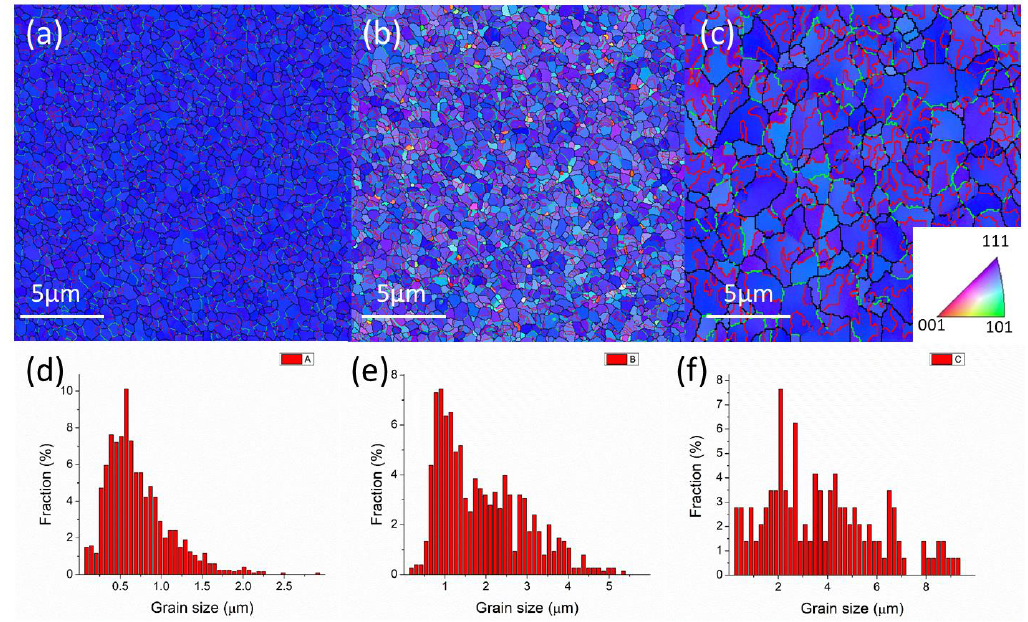
Figure 2. Plan-view grain orientation maps (OIMs) of highly <111>-oriented nt-Cu foils, which were deposited with additives ( a ) A, ( b ) B, and ( c ) C. The inverse pole figure in ( c ) indicated that the blue regions in the OIMs were <111>-oriented grains. The distribution of the columnar grain size of ( d ) type-A nt-Cu, ( e ) type-B nt-Cu, and ( f ) type-C nt-Cu.